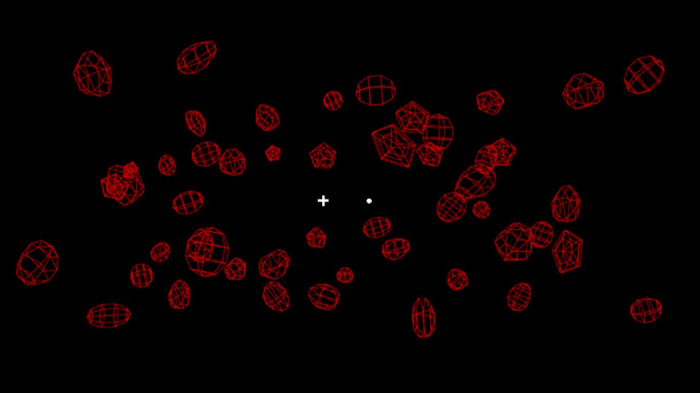
A single frame (monocular view) of an example stimulus from Experiment 1. Stimuli comprised a stereoscopically presented three-dimensional array of red wireframe background objects with a central fixation cross and probe dot to the right or left of fixation.